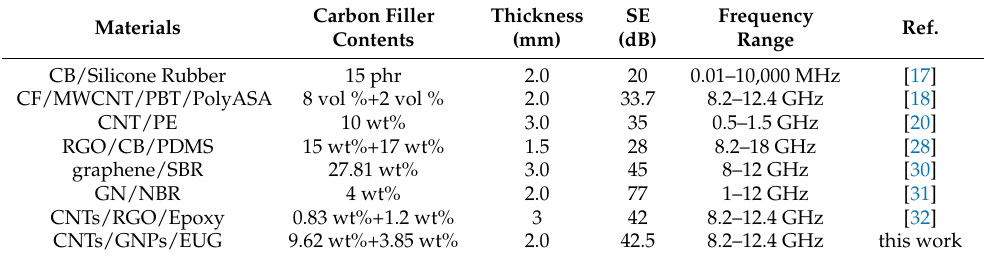
Table 1. Comparison of EMI shielding properties of CNT/GNP/EUG composites with other